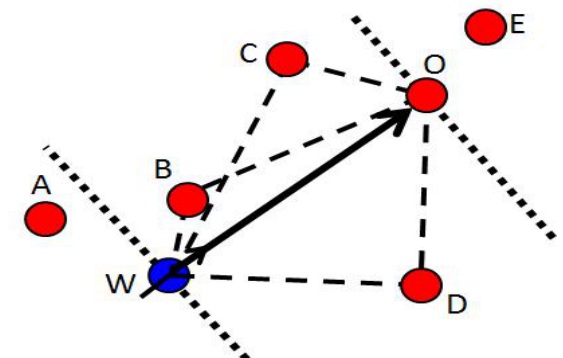
Figure 4—Indirect injection-production connections